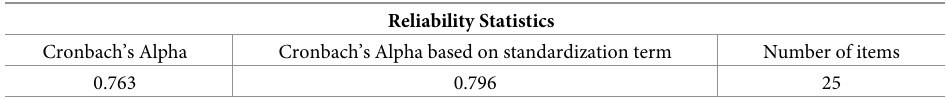
Table 1. The reliability